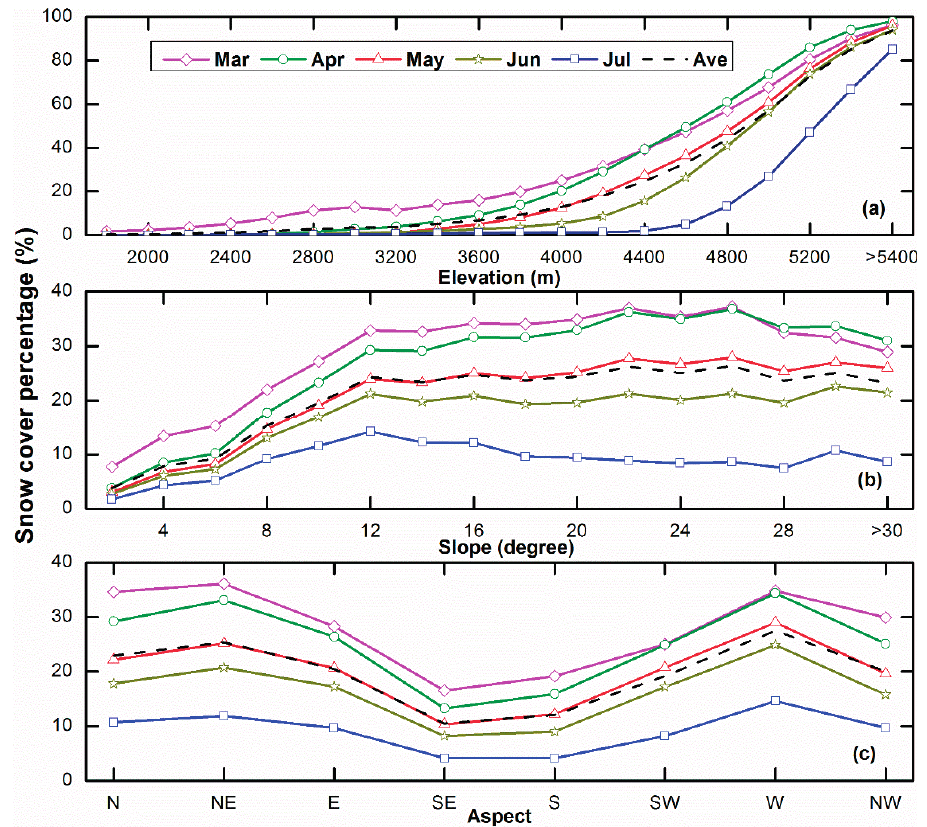
Figure 5. Mean SCPs in snowmelt season (March to July) of hydrological years from October 2002 to September 2012 and in different ( a ) elevation, ( b ) slope, and ( c ) aspect